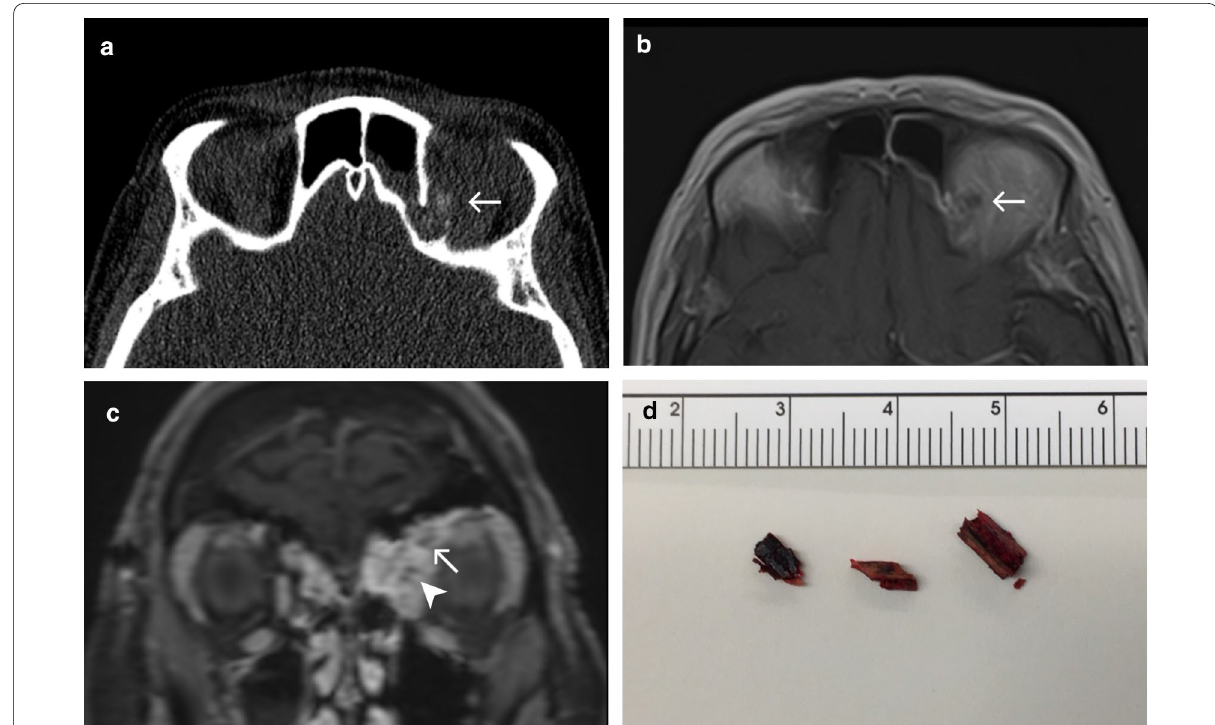
Fig. 3 Intraorbital wood. Axial CT image ( a ) and axial T1‑weighted MRI post‑contrast ( b ) demonstrate a small structure close to the orbital roof (arrow), which is moderately hyperdense and hypointense. There is a bony defect in the adjacent wall of the frontal sinus. Coronal T1‑weighted MRI with fat saturation post‑contrast ( c ) reveals the aforementioned object (arrow), two more small punctate hypointense foci (arrowheads) and extensive enhancement of the surrounding orbital soft tissues and sinus mucosa. Differential diagnosis for the hypointense structures at this point includes the presence of foreign objects and dislocated bone fragments. Based on MRI alone, abscesses and emphysema should also be considered, but the appearance of a hyperdense object in CT images helps narrow the differential in this case. d A photograph of three wood pieces after their surgical removal